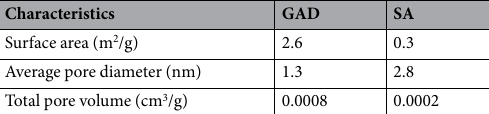
Table 1. Physicalproperty of GAD and